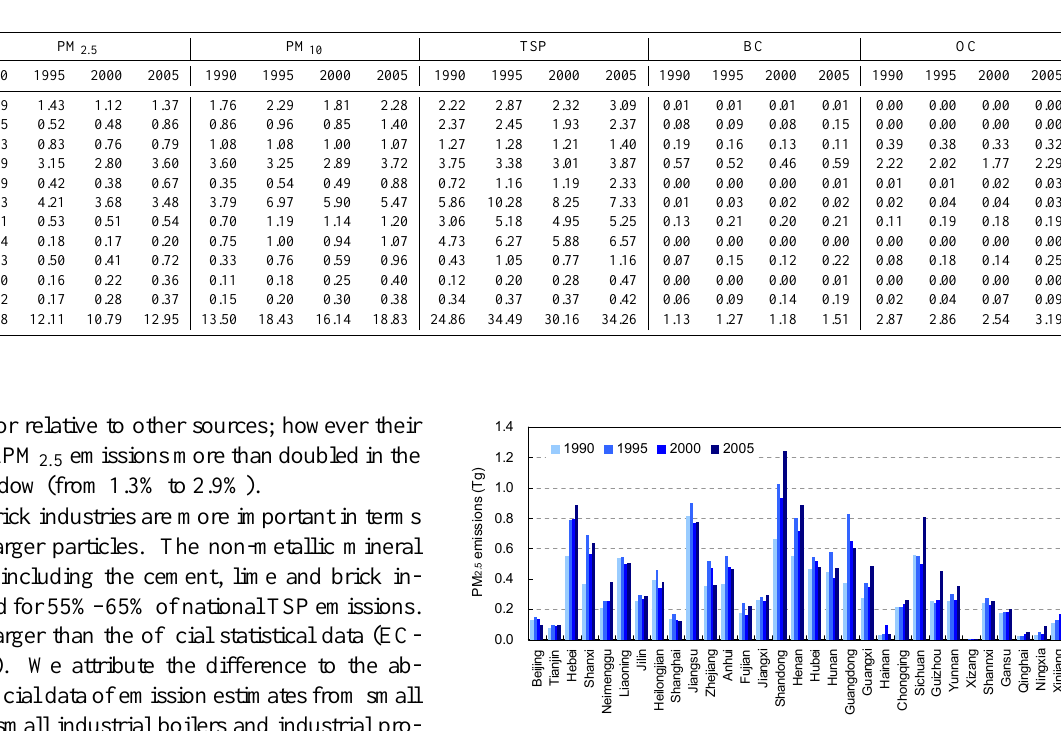
Table 9. Sector breakdown emissions of PM 2 . 5 , PM 10 , TSP, BC and OC in 1990, 1995, 2000 and 2005 (Tg).